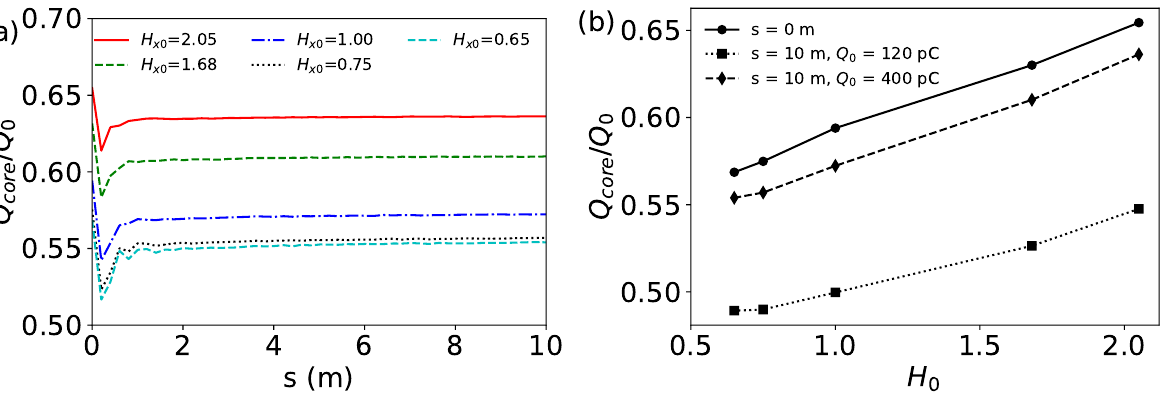
Figure 7. ( a ) Evolution of the charge fraction Q core / Q 0 within the core range of 400-pC witness beams. Different SG spatial profiles are denoted by their initial halo parameters H 0 . ( b ) Results for both the 120-pC and 400-pC beams. The initial value of Q core / Q 0 (denoted by the black solid line with dots) is the same for both charge